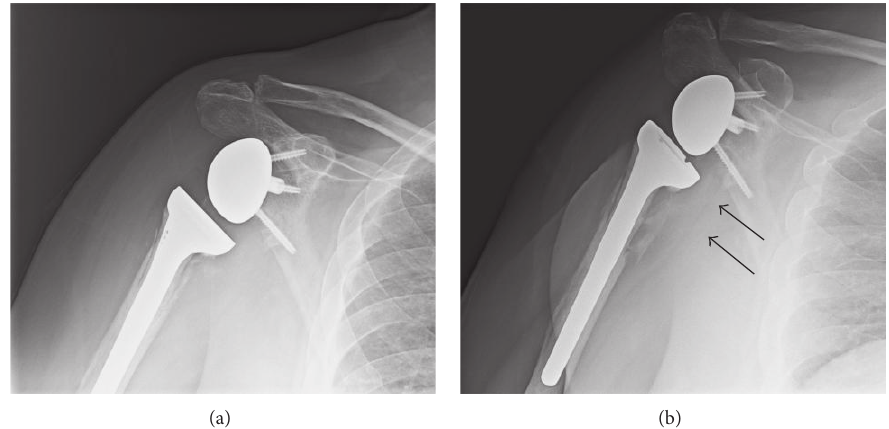
Figure 5: Radiograph showing (a) the reverse shoulder arthroplasty five months after implantation and (b) the reverse shoulder arthroplasty with the enlarged lucencies (arrows) at 18 months after implantation, which is just prior to its